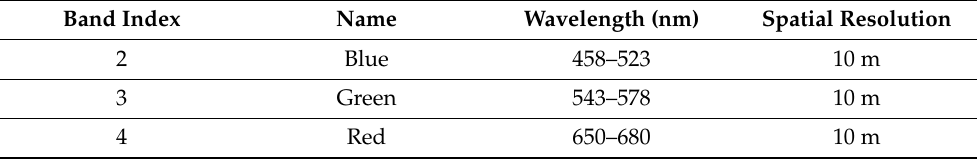
Table 2. Spectral and spatial configurations of Sentinel-2 data used in the